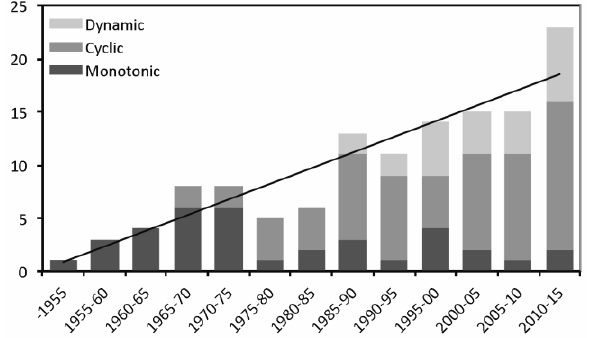
Figure 16. Trend of experimental work for infilled frame.